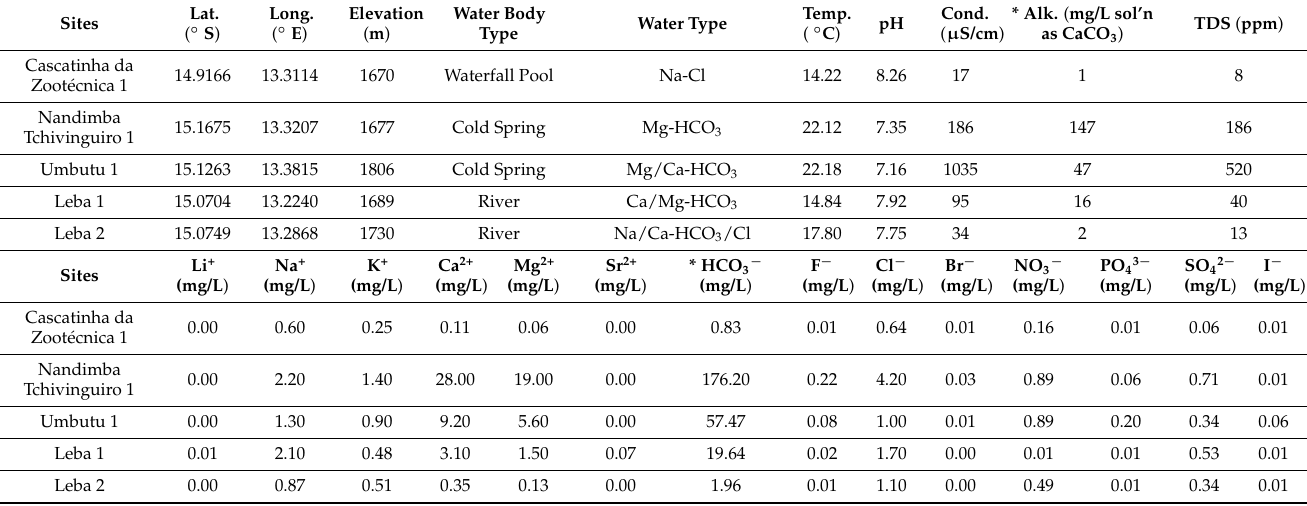
Figure 2. Satellite image from Google Earth of the sampled sites. A field photo from each site is included. Table 1. Collected and calculated physical and chemical parameters of the sites including water temperature (Temp.), pH, conductivity (Cond.), alkalinity (Alk.), Total Dissolved Solids (TDS), and major cations and anions. Measurements with an asterisk (*) were calculated using Geochemist